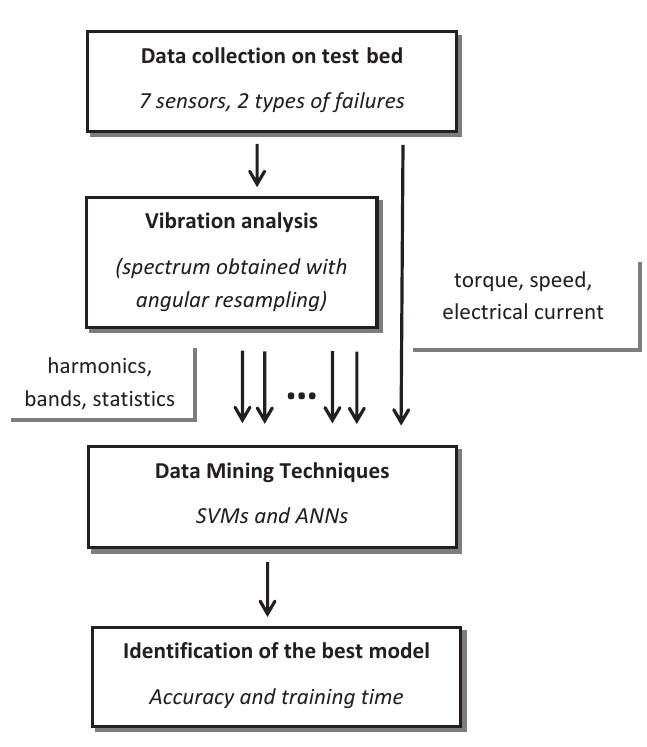
Figure 1. Diagram of the proposed